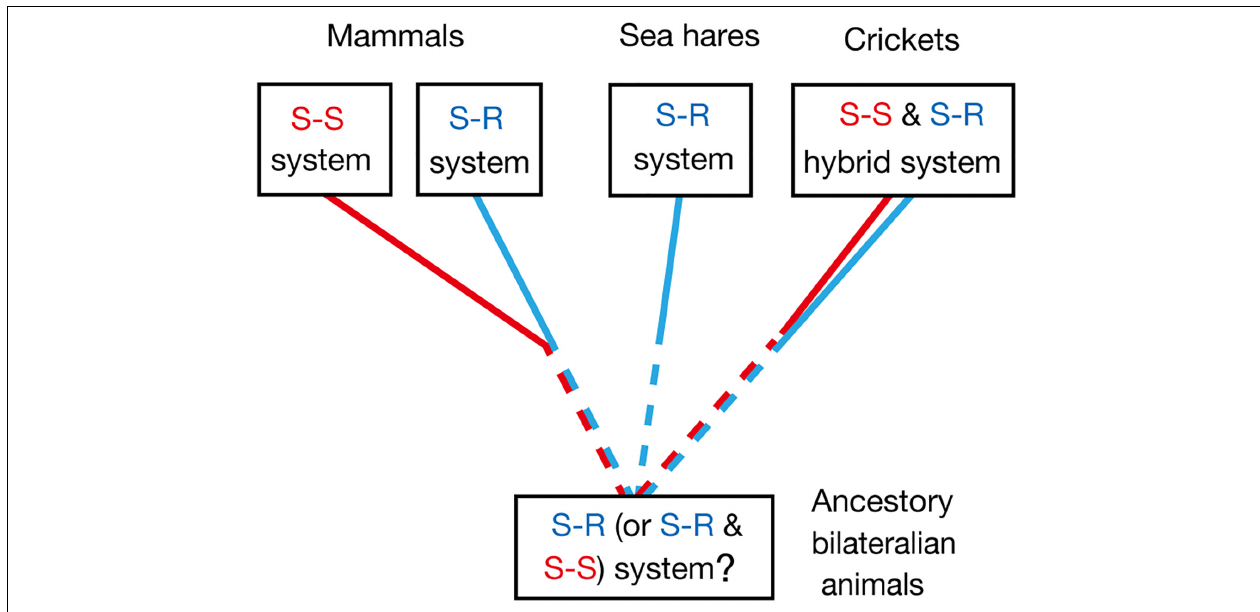
FIGURE 4 | Evolutionary considerations for the S-R type and S-S type Pavlovian conditioning systems, which can be discriminated by US devaluation. Pavlovian conditioning of gill withdrawal response in the sea hare Aplysia can be judged as S-R type from its neural circuitry mechanisms (Kandel, 2001). Pavlovian conditioning systems in mammals and birds are in many cases an S-S type, though S-R type conditioning systems are also present (Holland, 2008; Mazur, 2017). Olfactory conditioning in crickets can be characterized as an S-S and S-R hybrid type. Pavlovian conditioning has been reported in planarians (Prados et al., 2013), which are evolutionary-basal bilaterian animals. Investigations of the effect of US devaluation on execution of a CR in planarians and other invertebrates are needed for obtaining more insights into the evolution of Pavlovian conditioning